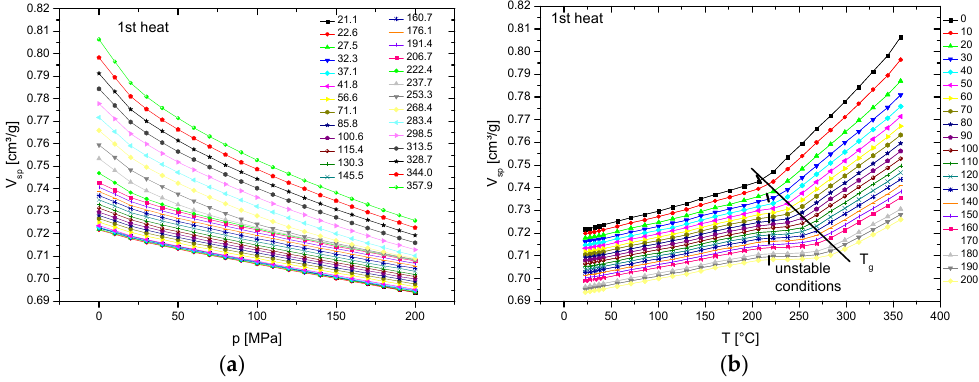
Figure 3. ( a ) Isotherms of PES 4100P obtained with rising temperature (legend gives T in °C) and ( b ) isotherms converted to isobars (legend gives pressure in MPa).